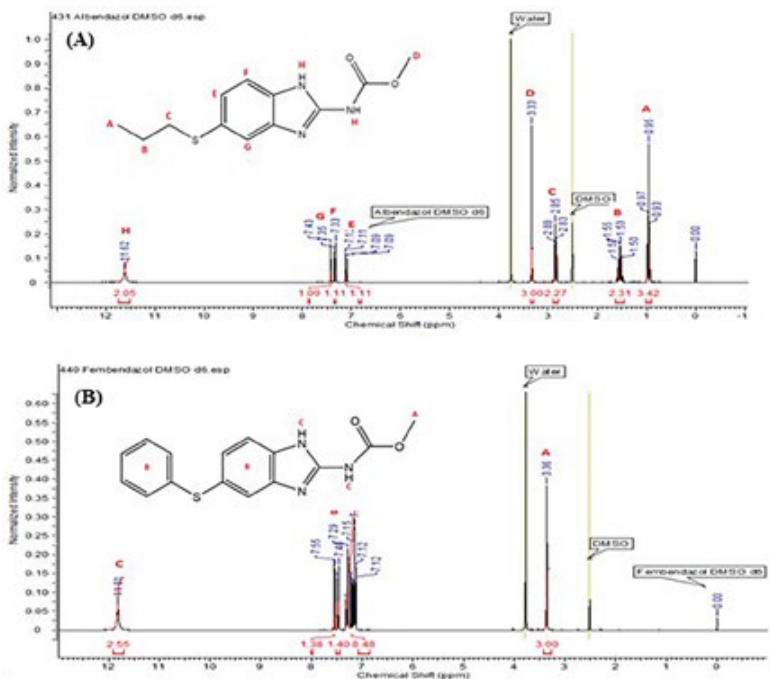
FIGURE 2 - 1 H-NMR spectra of ABZ (A) and FBZ (B) recorded in 300 MHz